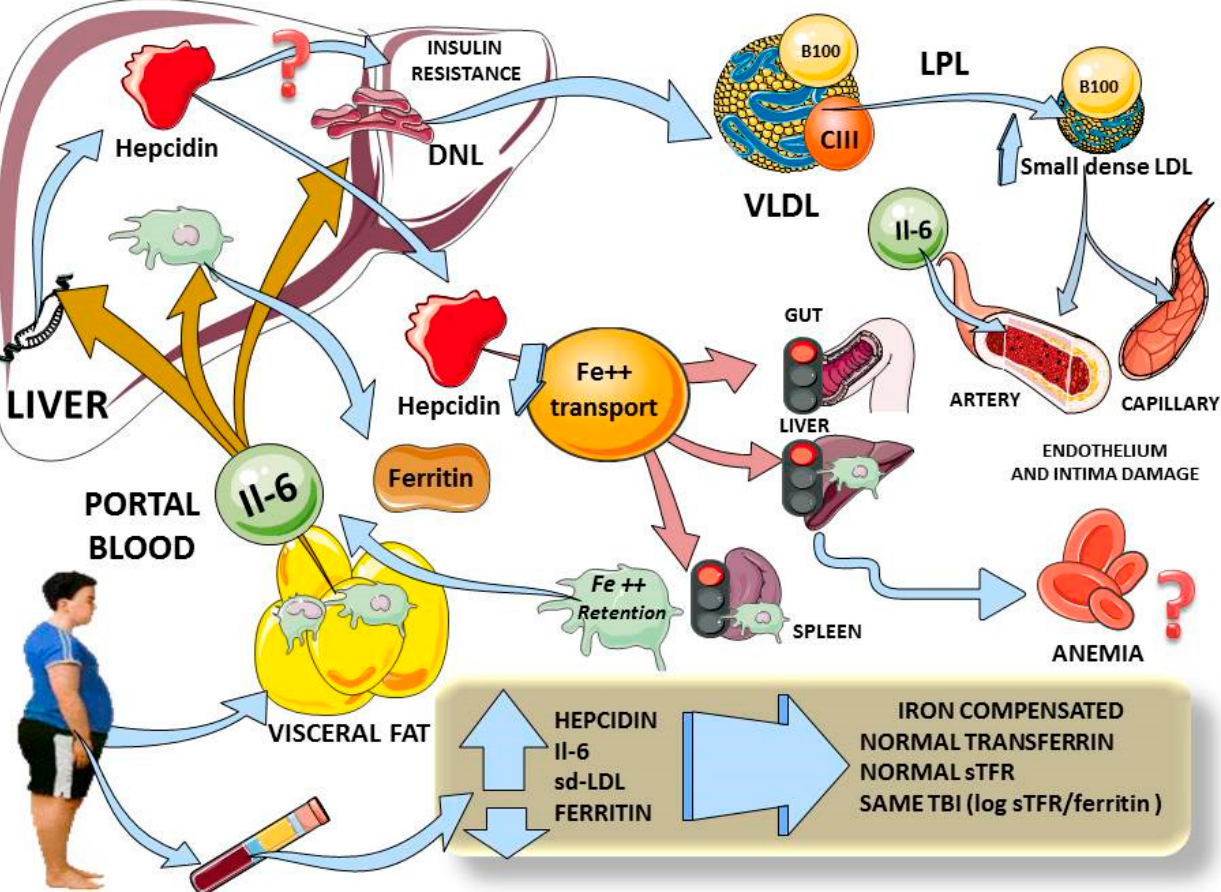
Figure 2. Diagram summarizing our findings and plausible physiological mechanisms. Adolescents with obesity have increased visceral fat, and we found increased levels of IL-6 which, via portal circulation, reach the liver to simultaneously induce hepcidin expression, Kupffer cells’ ferritin secretion and hepatic insulin resistance (3 beige arrows). Higher levels of hepcidin would curtail iron entry from gut, liver and spleen macrophages (pink arrows) which, in chronic stimulation, would lead to anemia. Moreover, iron retention activates macrophages to secrete even more IL-6. Hepatic insulin resistance induces lipogenesis, leading to high serum VLDL and small dense LDL, which are atherogenic and damage endothelium. In adolescents with obesity, we demonstrated increases in hepcidin, IL-6 and small dense LDL, all correlating with hepcidin. Ferritin levels were also high, but, as shown by total body iron measurement, did not appear to account for iron overload but rather for inflammation. All indexes of iron status showed no difference between lean and obese participants. This diagram was designed in part using Servier Medical Art: https://smart.servier.com (accessed on 29 November 2020). DNL: de novo lipogenesis; VLDL: very low density lipoprotein; sd-LDL: small dense LDL; TBI: total body iron; sTFR: soluble transferrin receptor.